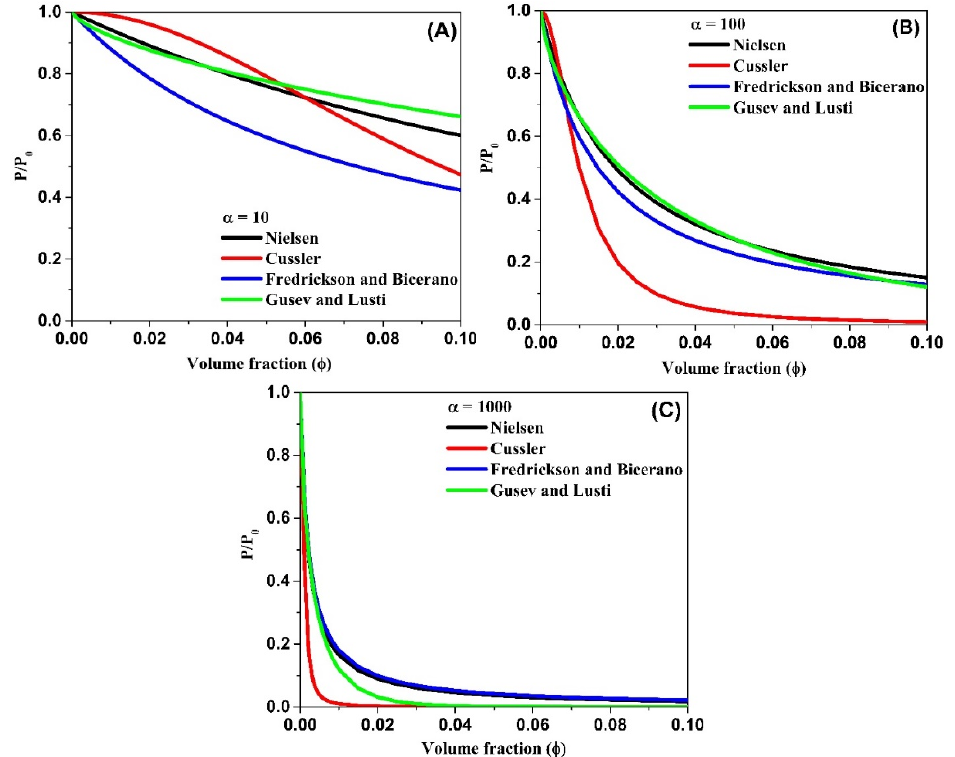
Figure 9. Prediction plots of relative permeability for different models at a fixed aspect ratio, ( A ) α = 10, ( B ) α = 100 and ( C ) α = 1000.